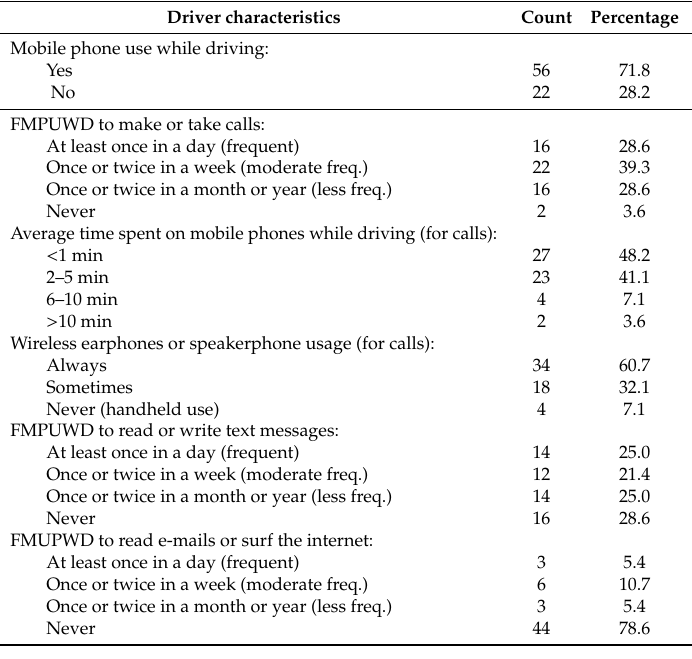
Table 1. Frequency of Mobile Phone Use While Driving